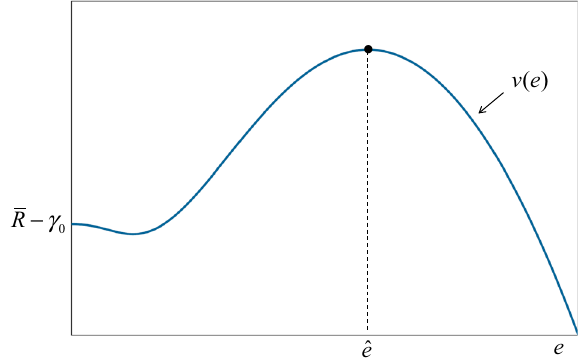
Fig. 2 Supervisor’s payoff